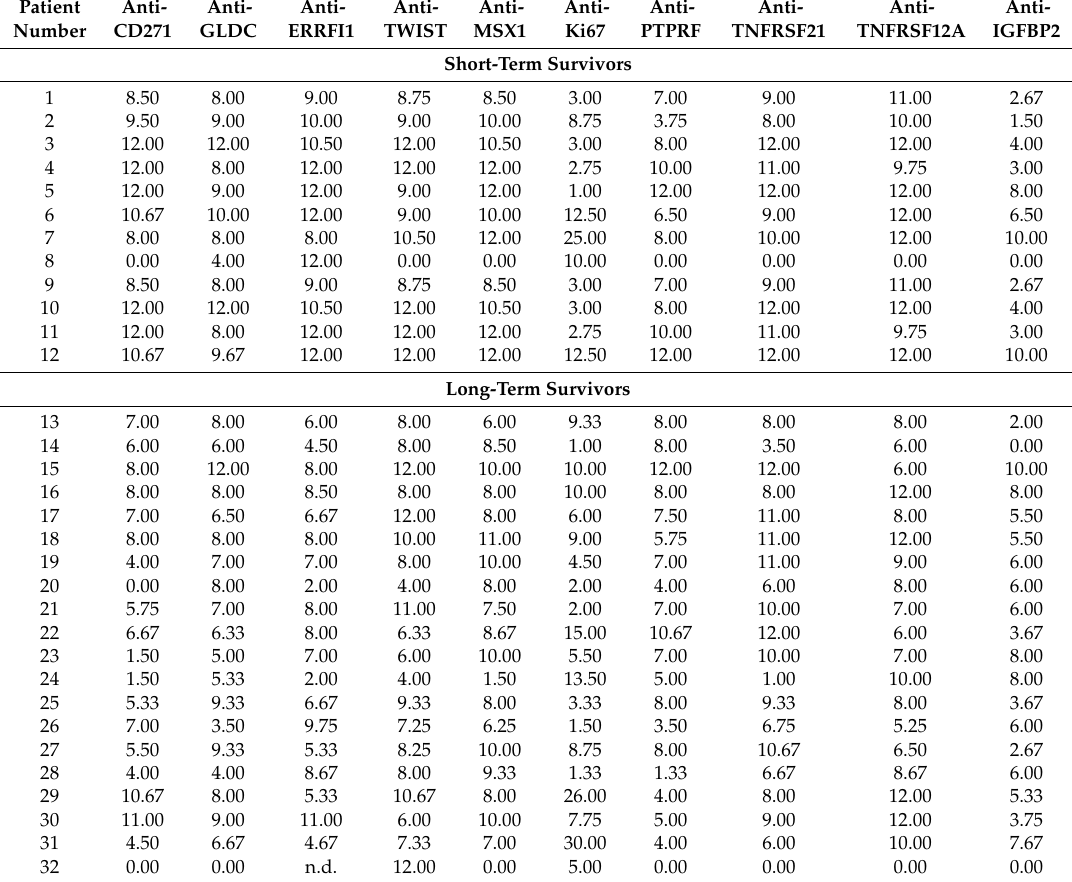
Table 1. Immunohistochemistry (IHC) scores for each antibody (survival group). Patient Number